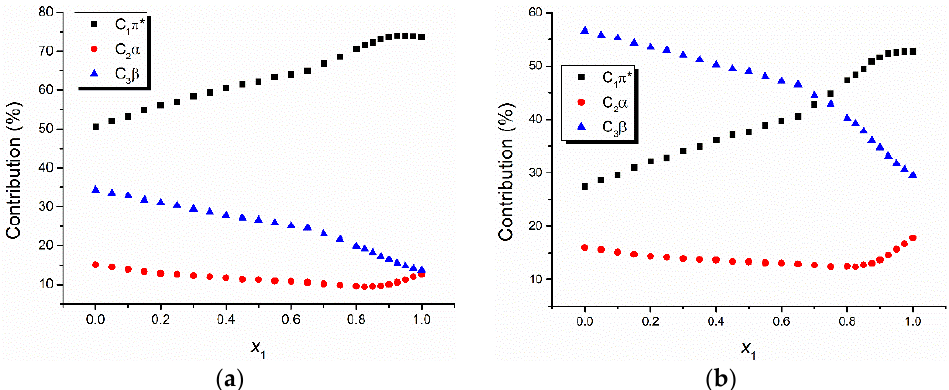
Figure 3. The contribution (percentage) to the spectral shift of universal and specific interactions for 4-tolyl-1,2,4-triazol-1-ium phenacylid (TTPY) ( a ) and 4-tolyl-1,2,4-triazol-1-ium-4 ’ -nitro-phenacylid (TTNPY) ( b ) in binary solvent mixture water + ethanol.